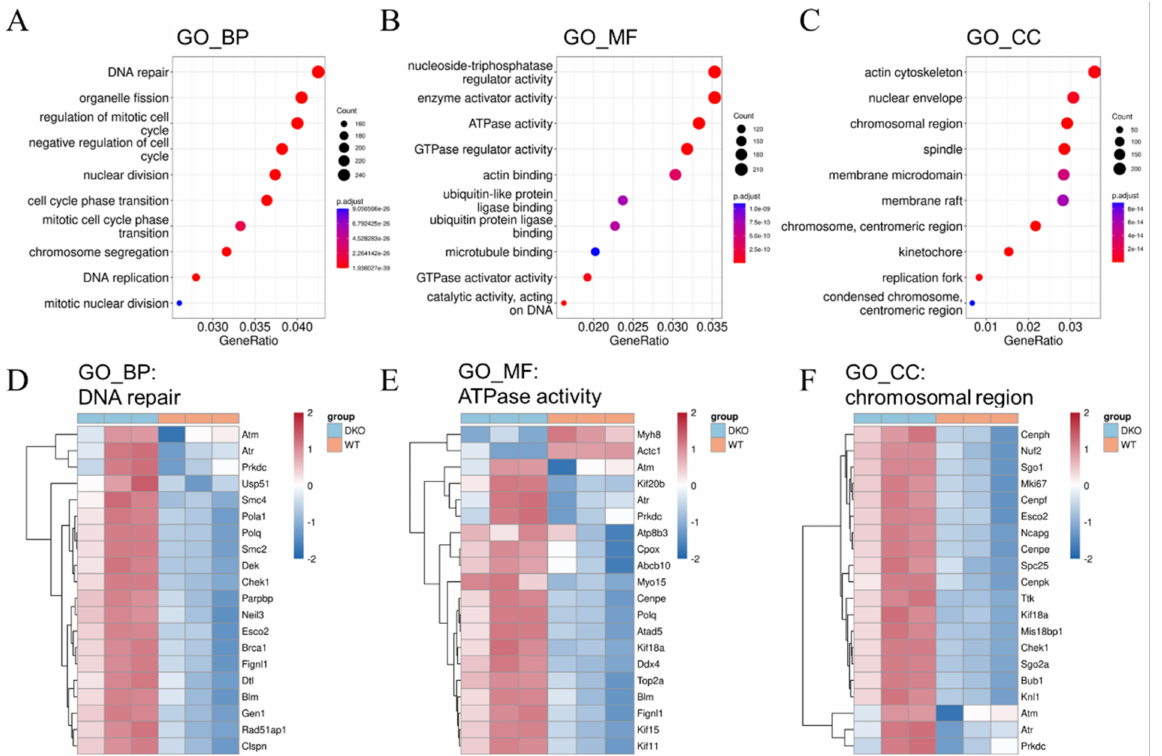
Figure 3. GO analysis of DEmRNAs in 14-month-old DKO male mice spleen. ( A ) GO-BP; ( B ) GO-MF; ( C ) GO-CC. Colored dots represent the fold change in gene expression in different pathways. The y -axis represents the gene count. The x -axis gives enrichment analysis terms. Plot colors represent p -values and sizes represent gene numbers. ( D – F ) Heatmap for differentially expressed mRNAs enriched in DNA repair (BP), ATPase activity (MF), and chromosomal region (CC). Blue: DKO mice; red: WT mice. DEmRNAs: differentially expressed mRNAs; GO: Gene Ontology; BP: biological process; CC: cell